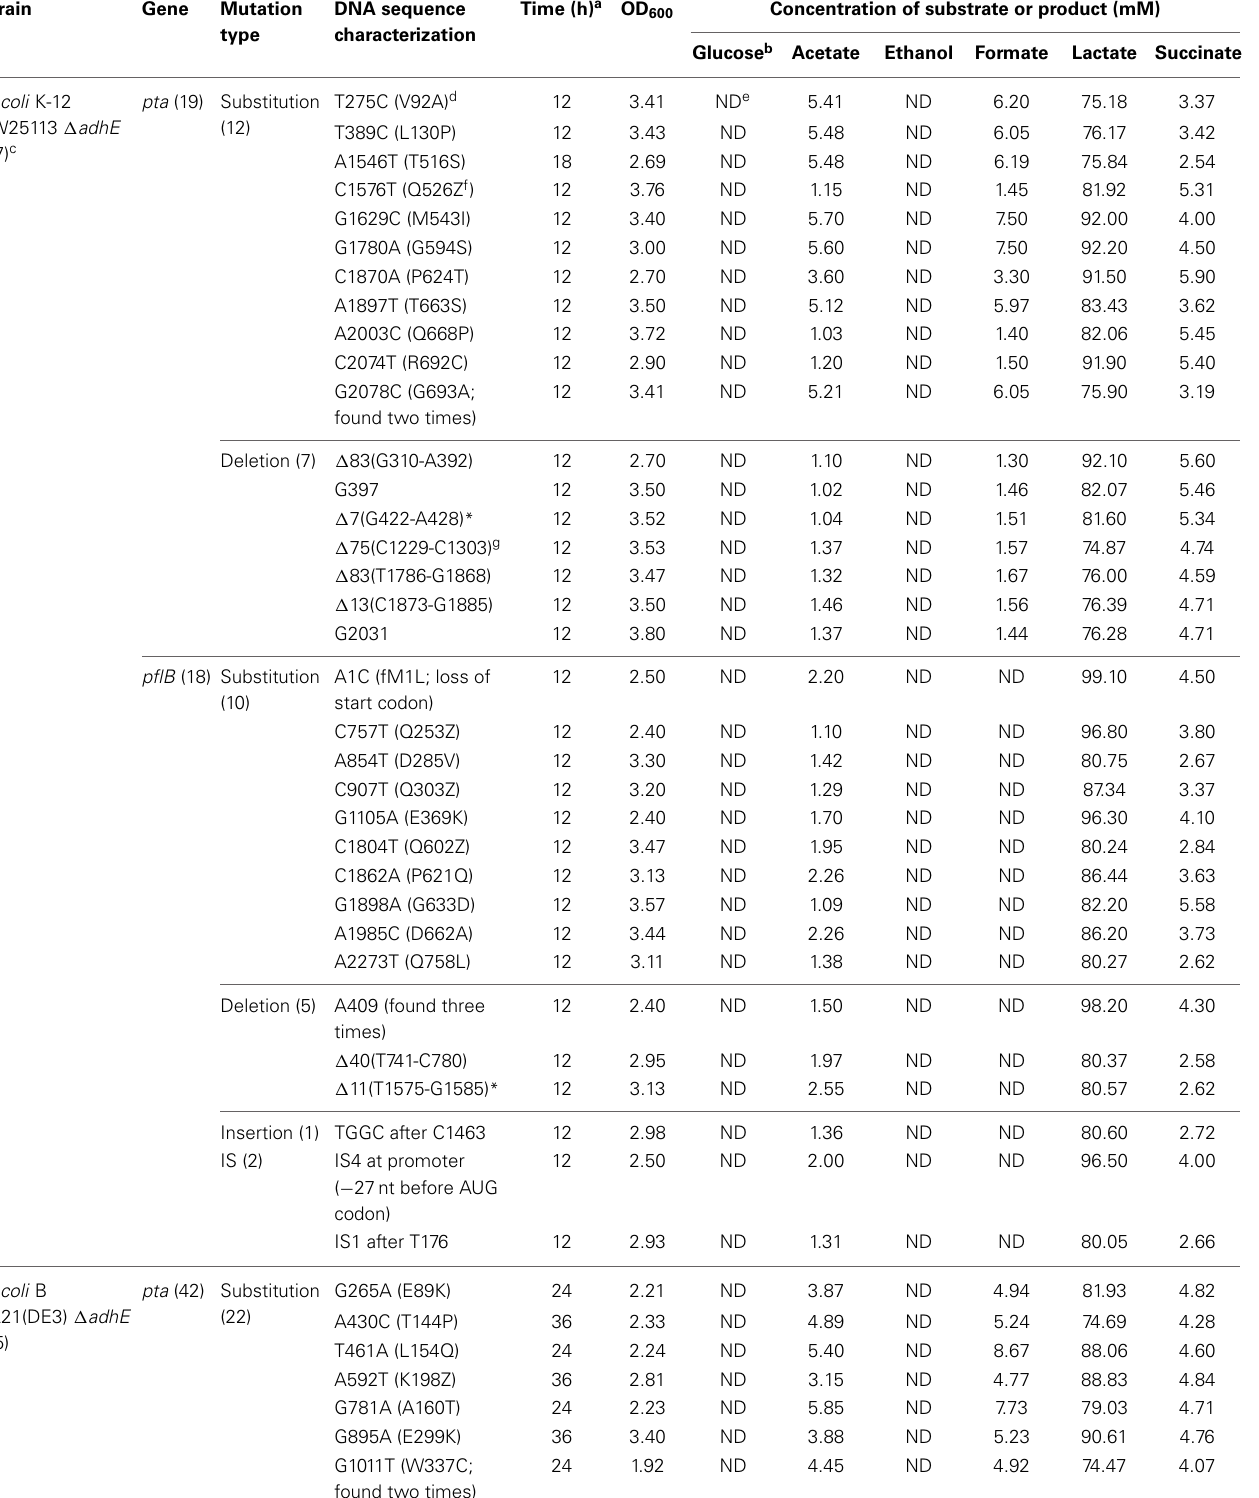
Table 3 | Mutation analysis and fermentation profiles of anaerobically-adapted E. coli K-12 (cid:2) adhE and B (cid:2) adhE cells. Strain